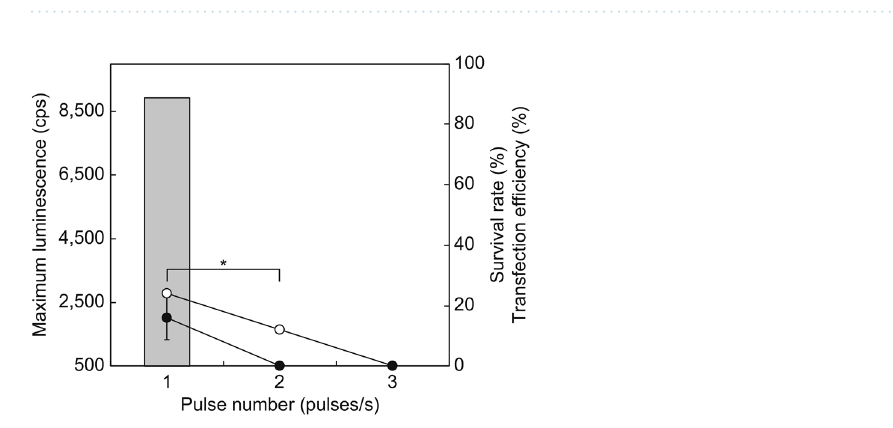
Figure 3. ( a – c ) Effect of voltage and pulse number on the survival rate and transfection efficiency of E. fetida . The electroporation conditions included a voltage of 28 V ( a ), 35 V ( b ), and 42 V ( c ), and 1–9 pulses/s at 1 s intervals for a duration of 60 ms. All experiments were performed using three groups of eight randomly selected mature earthworms. Open circles, survival rate; closed circles, transfection efficiency; bar graphs, maximum luminescence intensity.